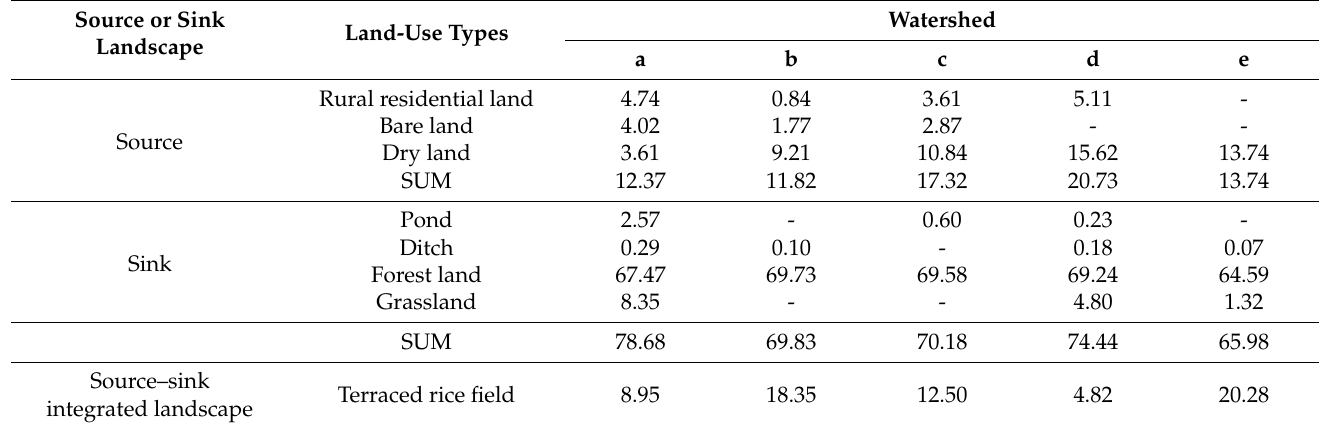
Table 4. Statistics of source and sink landscape areas in the five watersheds (unit: %).